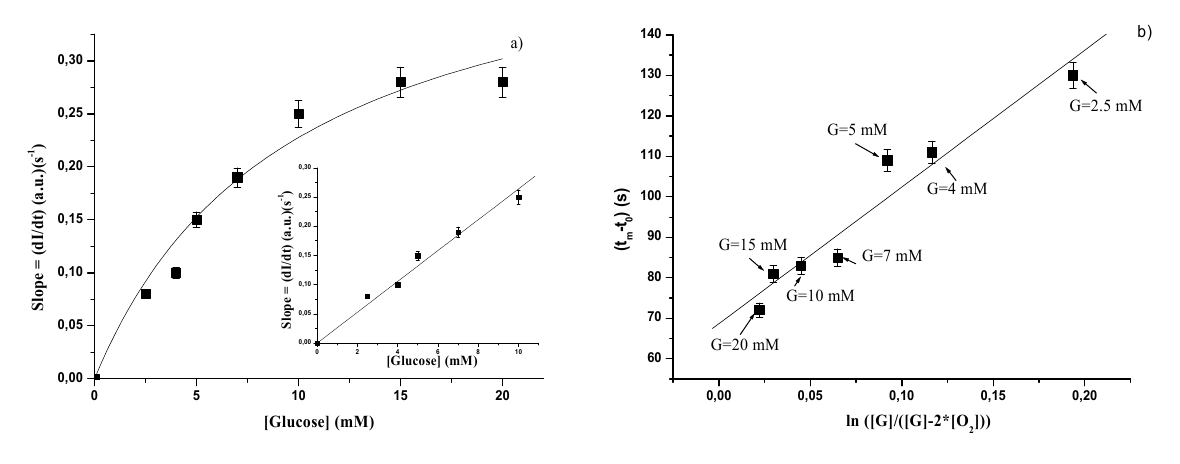
Figure 6. Immobilized GOD – (a) Slope of the intensity rise of fluorescence signal as a function of glucose concentration. Inset: glucose calibration curve. (b) (t